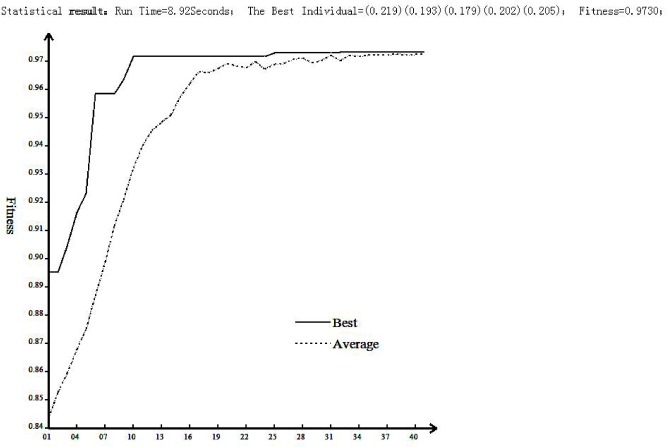
Computational results of the proposed GA-based weight optimization method.